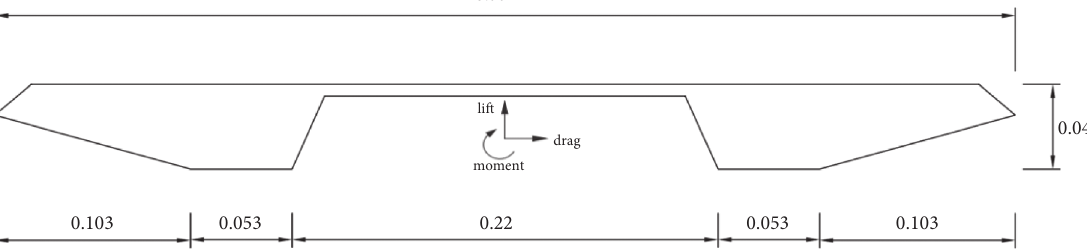
Figure 1: Deck section dimensions and shape ( m ). Table 1: Verification of grid amount independence.